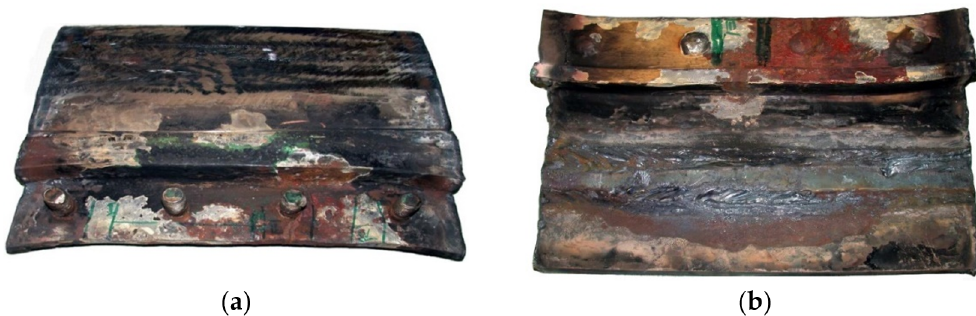
Figure 26. Macroscopic examination results (handy-size bulk carrier 30210 DWT): ( a ) view of a manhole section from the top of the deck and ( b ) view of a manhole section from the bottom of the